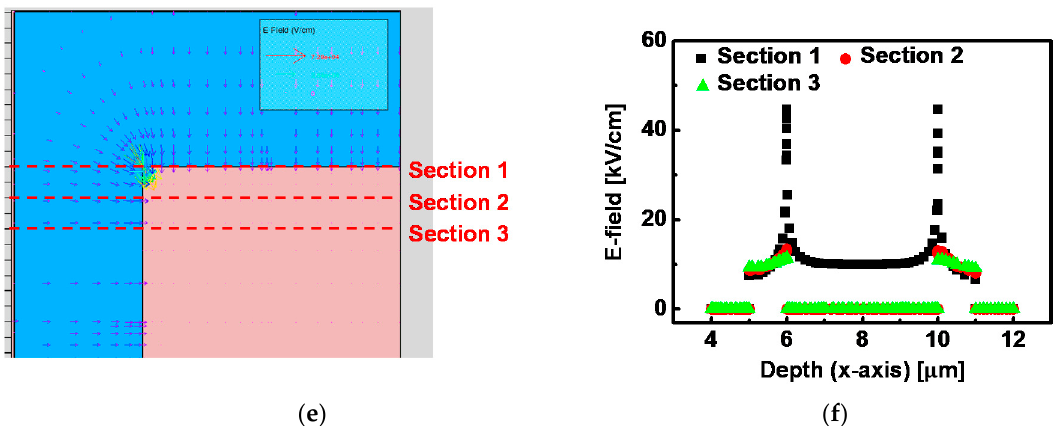
Figure 6. Enlarged device structure and extracted E-field distribution near the corner region with ( a , b ) larger ρ (round corner), ( c , d ) small ρ , and ( e , f ) ρ = 0 (perpendicular corner).